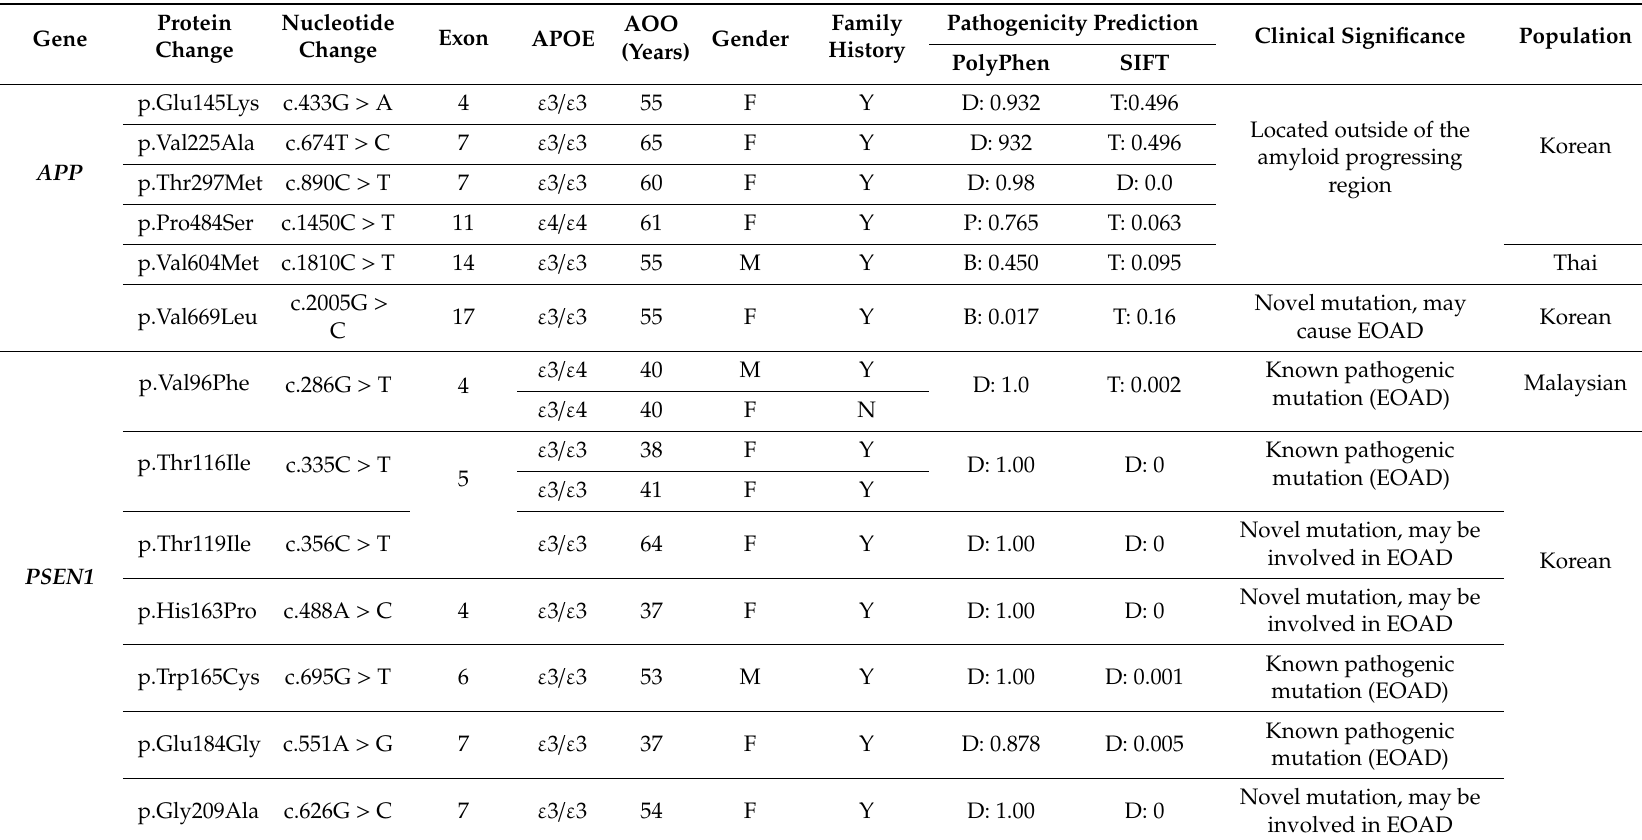
Table 1. APP, PSEN1, and PSEN2 mutations discovered in Asian early-onset Alzheimer’s disease (EOAD) patients between 2009 and 2018.